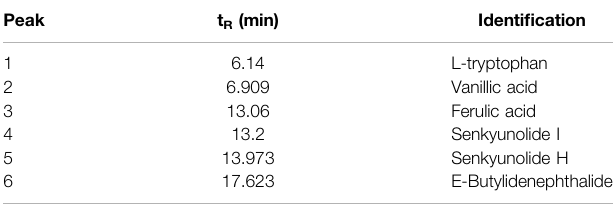
TABLE 2 | Chemical components identi fi ed from R . angelicae sinensis by HPLC- ESI/MS n . Peak t R (min)